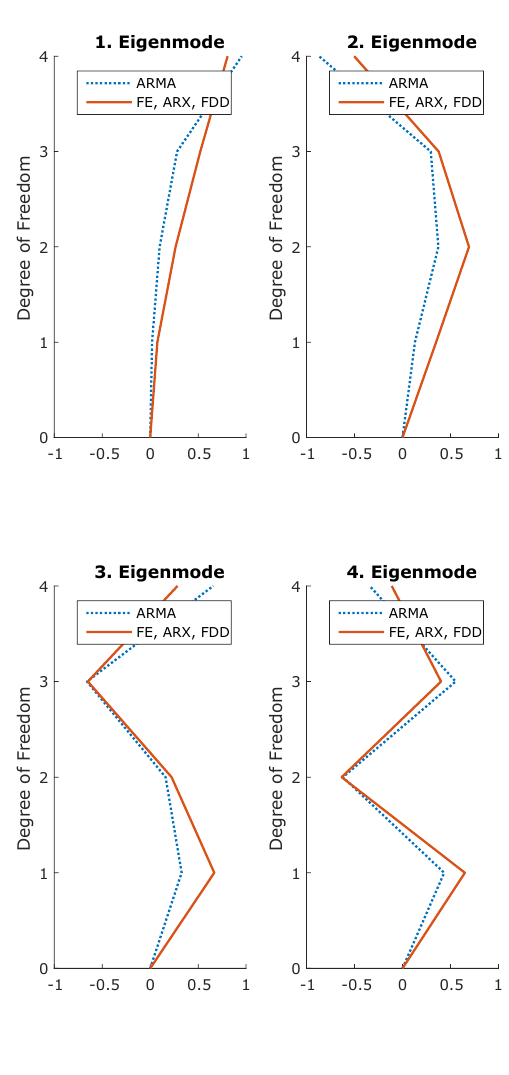
Figure 2. Comparison of the modal shapes of the 4-dof